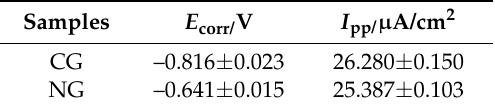
Table 1. Corrosion parameters of potentiodynamic polarization (PDP) for CG and NG Ti–6Al–4V alloys in simulated body fluid (SBF) solutions at 37 ◦